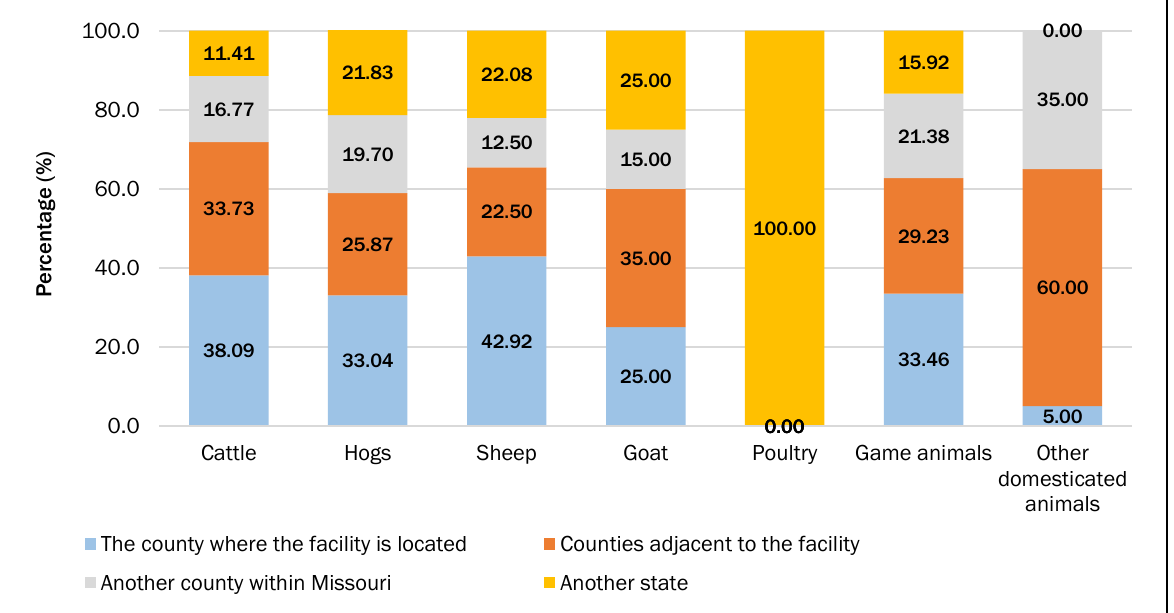
Figure 2. Sources of Animals ( N